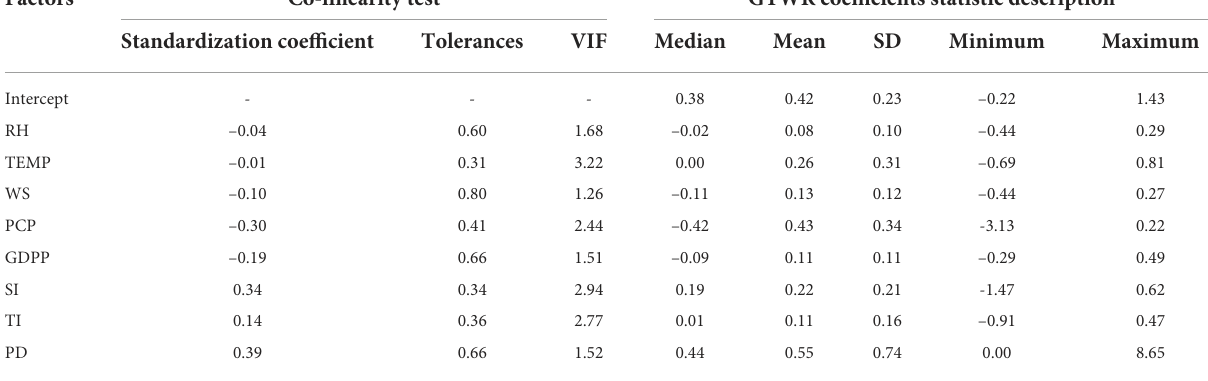
TABLE 3 Co-linearity test and coefficients statistic description of variables.